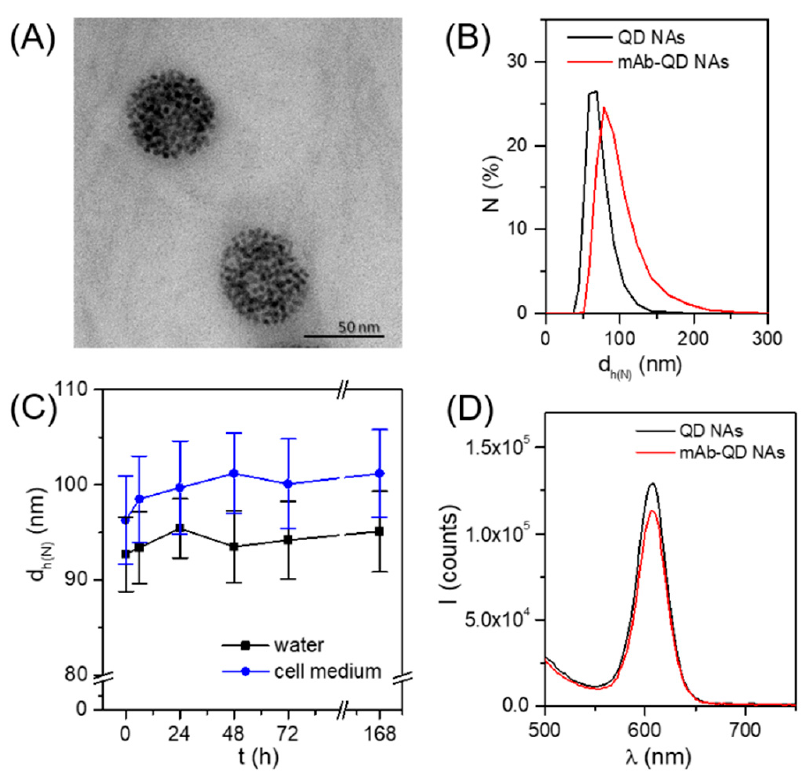
Figure 2. ( A ) TEM image of the QD NAs with a mean diameter of d QD NA = (58 ± 7) nm; ( B ) DLS number distributions of the hydrodynamic diameter (d h ) of mAb-QD NAs (d h = 93 ± 4 nm; polydispersity index PDI = 0.25) and non-modified QD NAs (d h = 68 ± 3 nm; PDI = 0.21); ( C ) colloidal stability in terms of hydrodynamic diameter over time of mAb-QD NAs in both water and cell medium; ( D ) fluorescence emission spectra of the mAb-QD NAs and non-modified QD NAs under excitation at 405 nm.